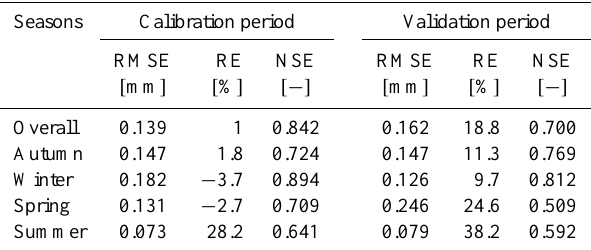
Table 2. Summary of overall and seasonal performance of the conceptual model during the calibration (September 2001 to Au- gust 2005) and validation (September 2006 to August 2011) peri-